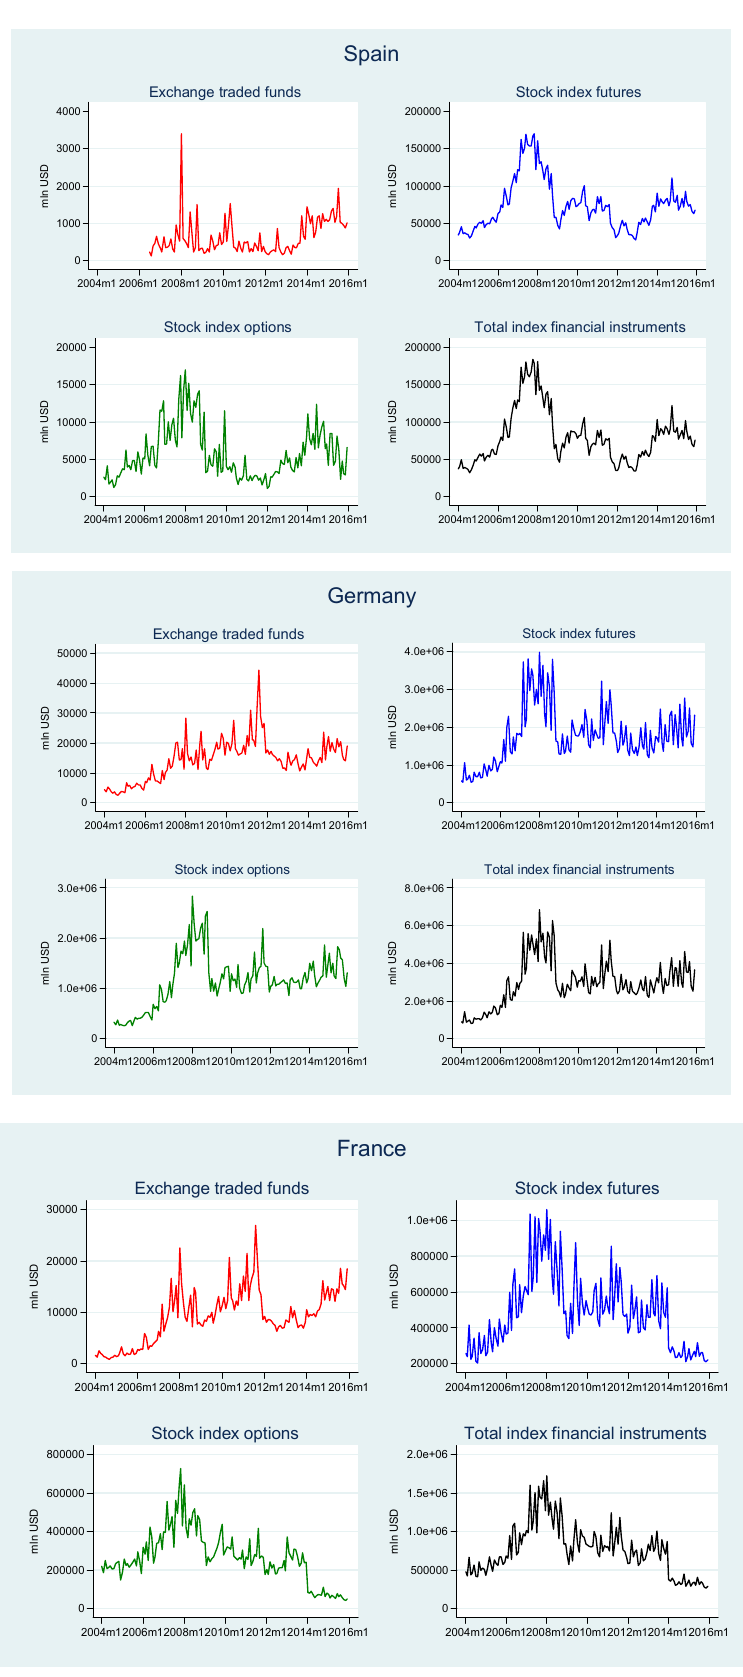
Figure A1. ETFs, stock index options, stock index futures and total index financial instruments—diffusion trajectories. 2004-2015 (monthly time series). Values in USD millions.